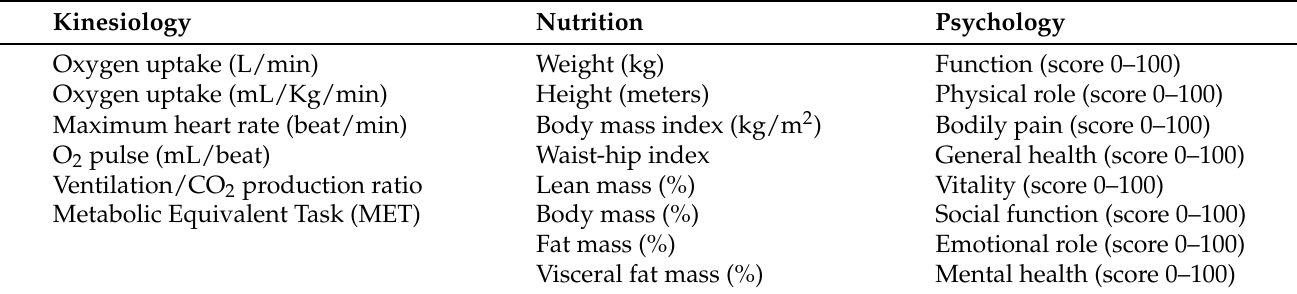
Table 2. Variables from the retrospective data used to develop the proposed model.